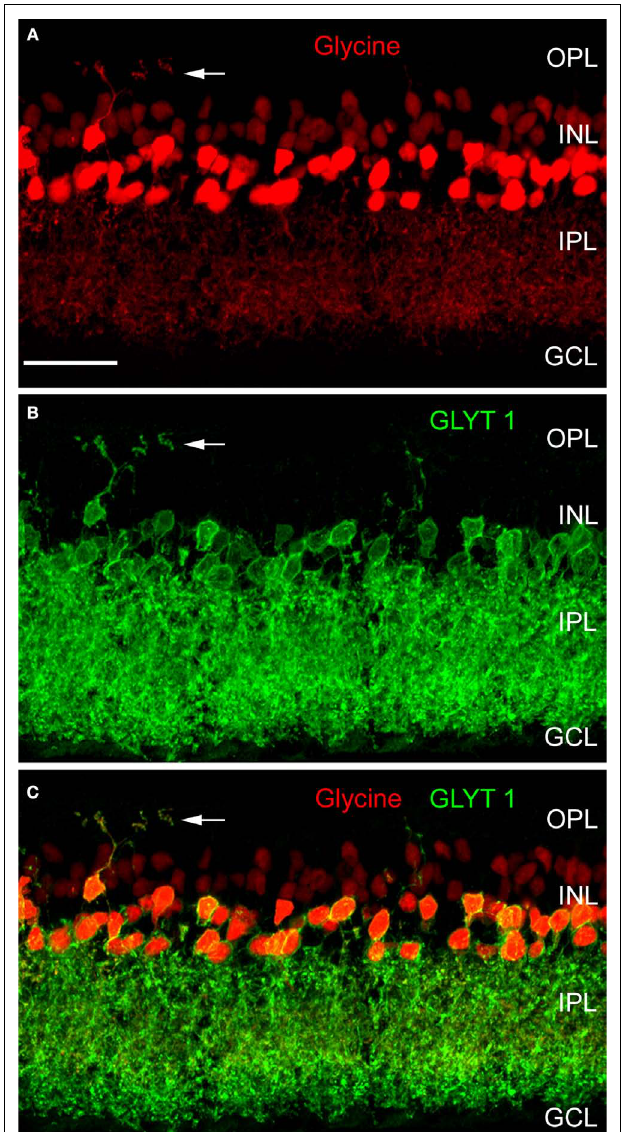
FIGURE 1 | Glycinergic amacrine cells of the mouse retina (modifi ed from Haverkamp and Wässle, 2000). A vertical section was double immunolabelled for glycine (red) and the glycine transporter GlyT1 (green). (A) Strong glycine immunofl uorescence is found in amacrine cells at the INL/IPL border. Weak glycine immunofl uorescence is also present in the cell bodies of ON-cone bipolar cells in the center of the INL. (B) GlyT1 immunofl uorescence is found in amacrine cell bodies and their dendrites descending into the IPL. (C) The superposition of (A) and (B) shows that only the amacrine cells but not the bipolar cells express GlyT1. The arrows indicate an interplexiform process ascending to the OPL (OPL: outer plexiform layer; INL: inner nuclear layer; IPL: inner plexiform layer; GCL; ganglion cell layer; Scale bar: 25